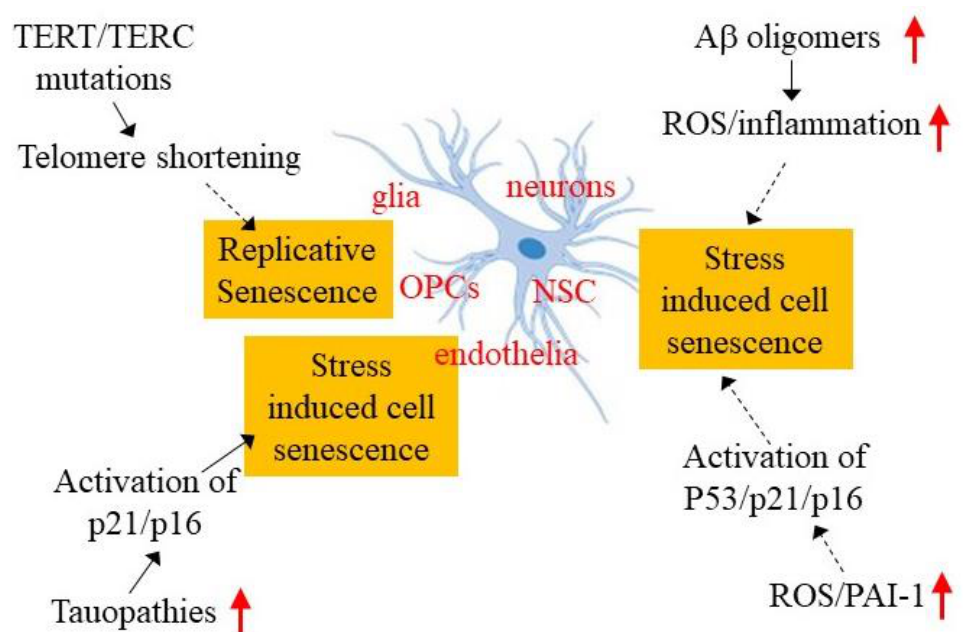
Figure 2. Potential mechanisms underlying brain cell senescence in AD. Various types of cells, including glia, oligodendrocyte precursor cells (OPCs), neuronal stem cells (NSCs), neurons, and endothelia, have been shown to undergo senescence in AD brain and/or AD model mice. Mutations in the telomerase reverse transcriptase (TERT) gene and telomerase RNA component (TERC), which leads to telomere shortening, hyperphosphorylated tau, increased A β oligomers, reactive oxygen species (ROS), and plasminogen activator inhibitor 1 (PAI-1) expression, are implicated in brain cell senescence in AD. Red arrows indicate increases in the amounts of these molecules.